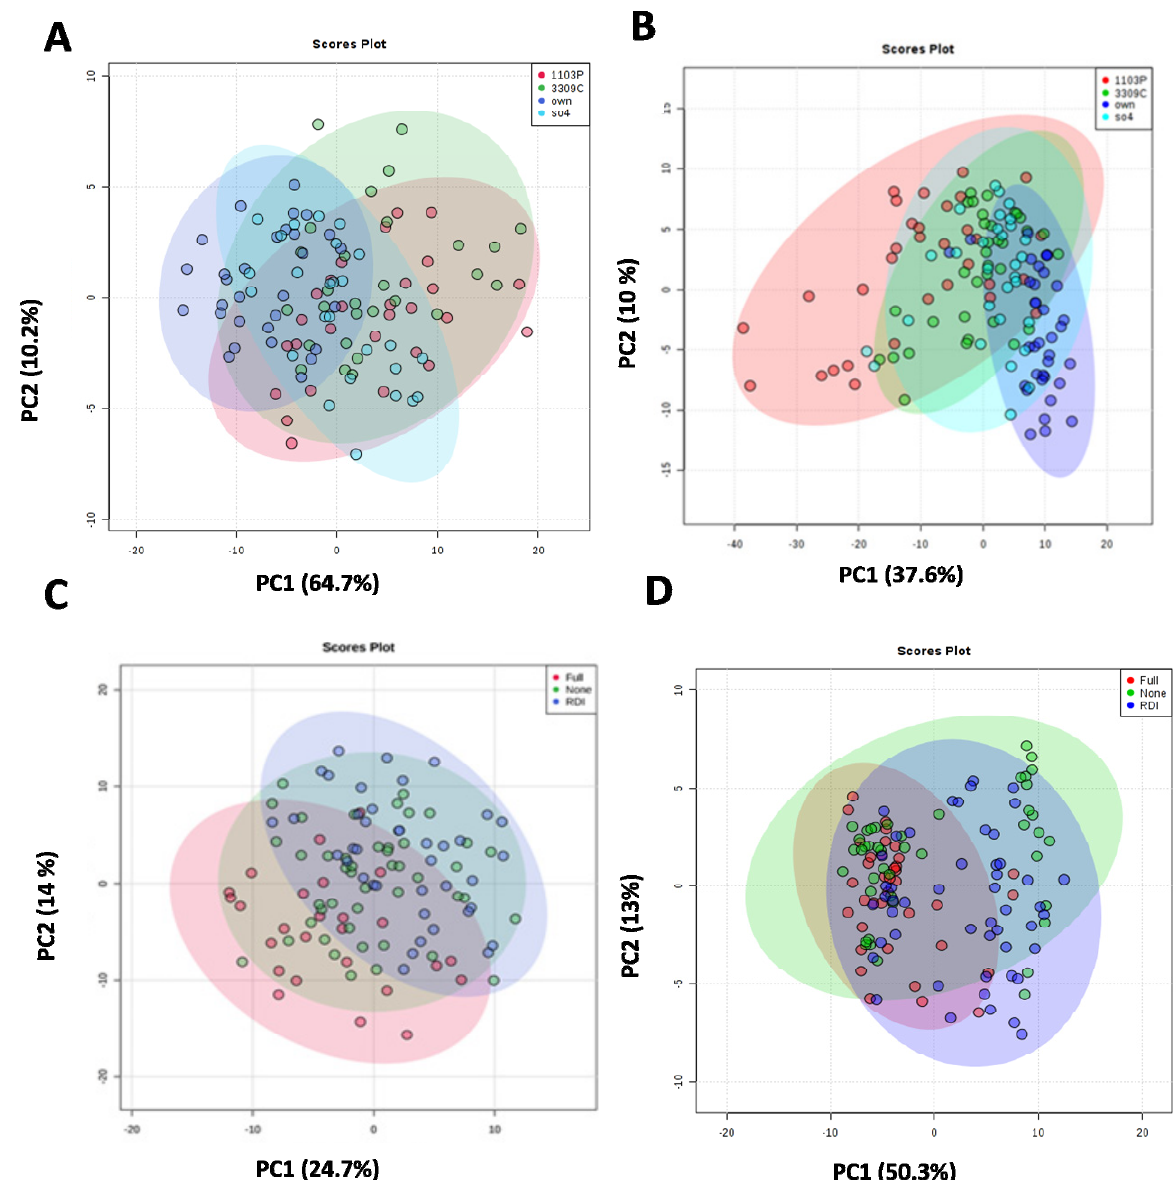
Figure 4. PCA scores plot of wine metabolite features separated by root system in ( A ) 2017 and ( B ) in 2018 regardless of the irrigation treatment. PCA scores plot of wine metabolite features separated by irrigation treatments in ( C ) 2017 and ( D ) 2018 regardless of the rootstock treatment. PCA was performed using log-transformed and autoscaled significant features.